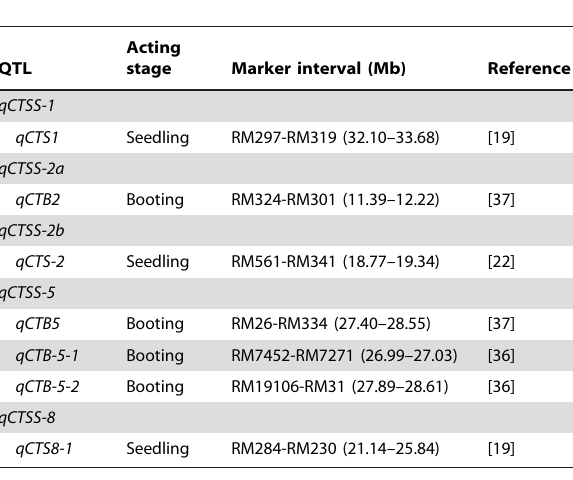
Table 4. Common QTL regions conferring cold tolerance in rice identified in the present study and previous studies.